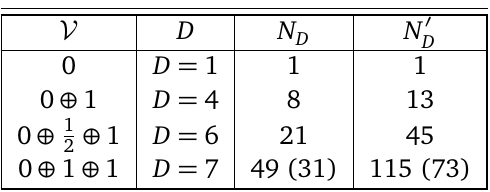
Table 1: Numbers of elementary tensors in each of the tensor classes defined by their virtual spaces V . The number of elementary C -symmetric tensors are shown in 4 v the third column. When the site C point group symmetry is broken to C , the N s D 4 v tensors are “split" into N (cid:48) tensors (fourth column). For D = 7, assuming “color" spin- D 1 exchange symmetry reduces the number of elementary tensors, as shown by the numbers in